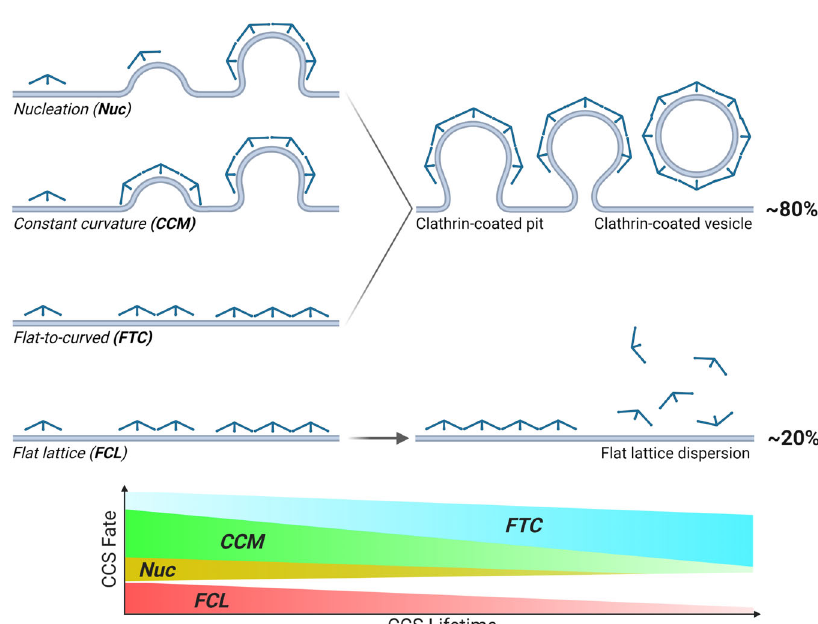
Fig. 5 Majority of CCVs form simultaneously with clathrin arrival in HUVECs. a HUVEC expressing CLCa-STAR, arrows = clathrin accumulations, scale bar = 20 μ m. Representative of 9 HUVECs and three independent repeats. b Western-blot analysis of STAR probe expression in HUVECs. Representative blot from three independent replicates. c Kymograph showing clathrin accumulation (cyan) and curvature formation ( fi re), full arrow = vesicle formation, dashed arrow = fl at clathrin lattice assembly. Curvature channel is translated 3 pixels to the right, scale bar = 5 μ m. d Quantitative intensity and Δ z traces for CCV and FCL, lighter cyan, magenta and orange = background mean and 2*SD above background, darker shaded band represents the SD of detected signal, red dashed boxes = clathrin signal signi fi cantly higher than threshold. e CMEanalysis of CLCa-STAR lifetimes separated on whether Δ z was generated (mean ± SEM, EGFP — Cyan, iRFP713 — magenta). f Histogram of lifetime distribution of curved and fl at CCS per µ m 2 , per minute — mean ± SEM. g Cumulative frequency of curved and fl at CCS per µ m 2 , per minute, mean ± SD, data was normally distributed, two-tailed unpaired t -test, p = 0.0064, * p < 0.01, means: Curved CCS = 0.00104, Flat CCS = 0.00028. (Data in e – g based on CCVs — n = 458 events, FCLs — n = 143 events, from 8 cells and three independent repeats). h Distribution of beginning of curvature formation measured as Δ z Beg − CLCa Beg [s]. i Density scatter plot of Δ z Beg − CLCa Beg [s] as a function of total CCP lifetime. j , k Distribution across three membrane bending models. Data from i was classi fi ed as in Fig. 3. Data represents three independent repeats, means and SD reported as a heat map in k . Data was normally distributed (one-sided Shaphiro-Wilk test, p > 0.05 for each lifetime cohort) and analyzed by two-way ANOVA (lifetime cohort — F (2,18) = 19.55, p < 0.0001; PM bending model — F (2,18) = 15.55, p = 0.0001; interaction — F (4,18) = 6.712, p = 0.0017). Tukey ’ s multiple comparisons test details in Supplementary Table 7, ns = not signi fi cant, * (CCM[5 – 19,20 s] vs FTC[5 – 19,20 s]) — p = 0.0278, * (Nuc (20-50s] vs FTC (20-50s] ) — p = 0.0423, *** p = 0.0007 (Data in h – k based on n = 283 events form 9 HUVEC cells and three independent repeats).